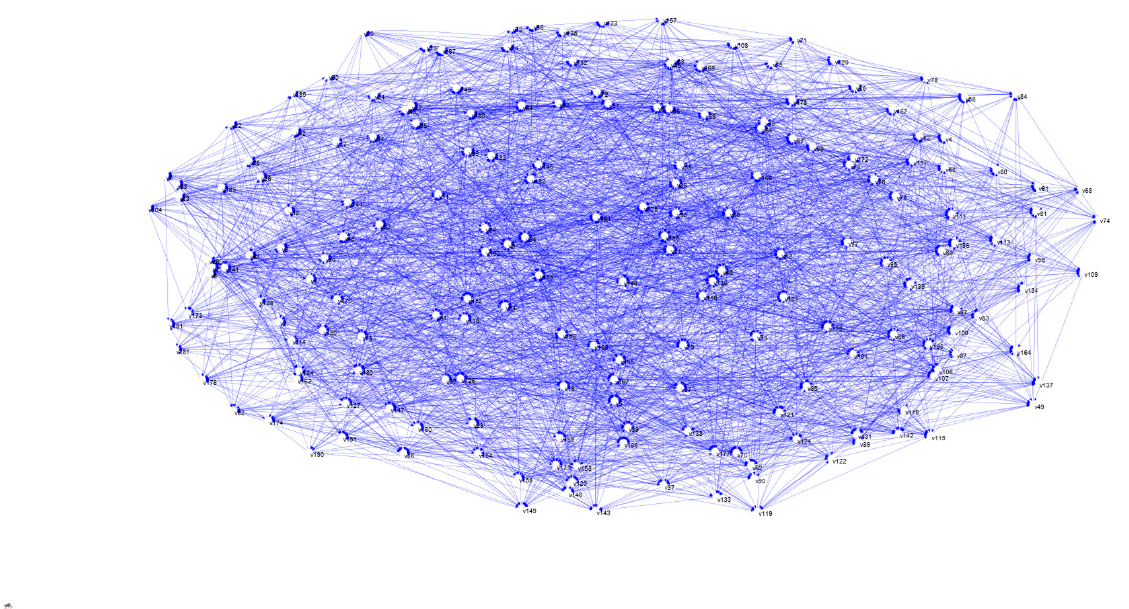
Figure 7. The equal-sized random network of the ENRRTP.